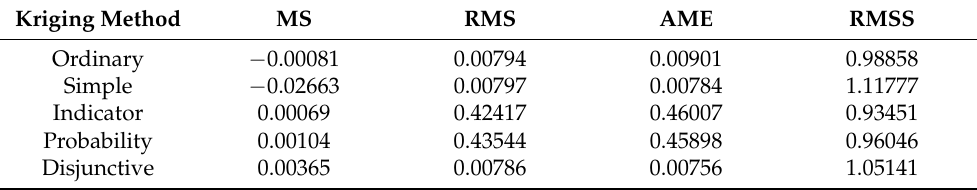
Table 1. The cross-validation results of five Kriging interpolation